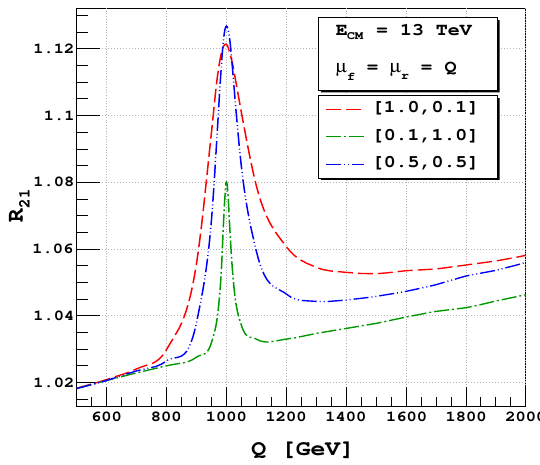
Figure 8 . K-factor of signal with respect to NLO at NNLO+NNLL level for different choice of k q and k g